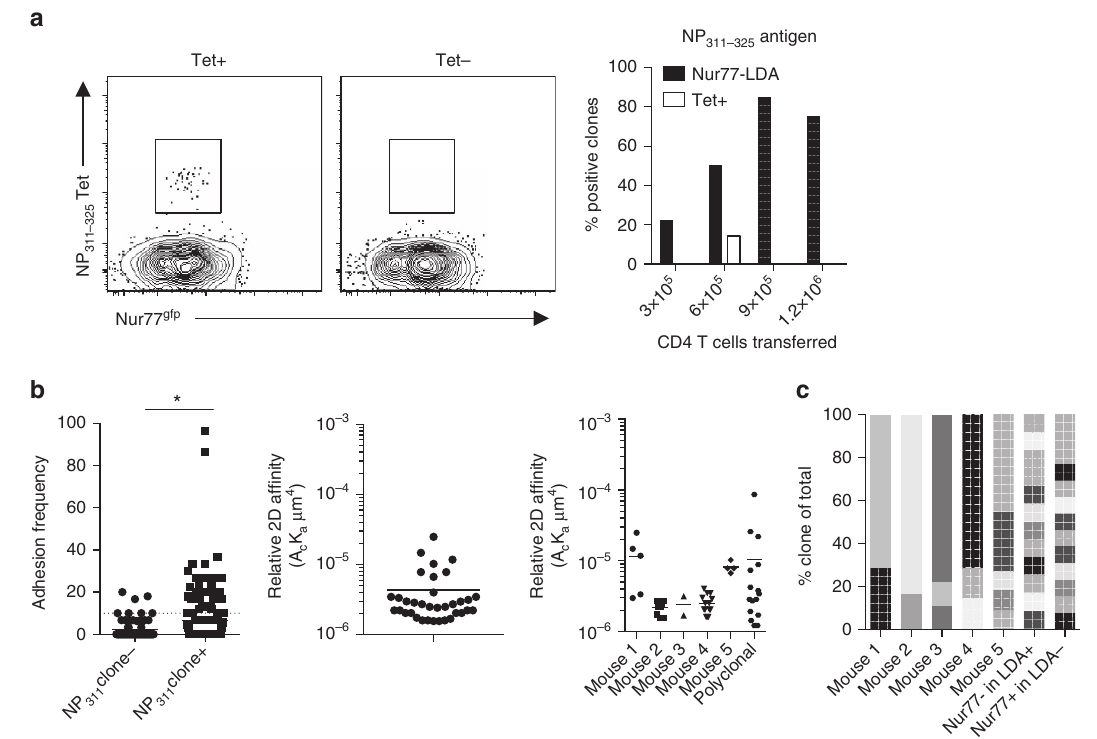
Figure 3 | In vivo LDA identifies low-affinity CD4 þ T-cell clones. ( a ) Representative NP 311–325 Tet staining in TCR a (cid:2) / (cid:2) LDA mice with both a Tet þ positive (left) and negative (right), with only 1 out of 34 mice possessing a Tet þ -positive clone. ( b ) MP on single CD4 þ Tcells isolated from positive and negative LDA mice as identified by CD69/Nur77 (data combined from two independent experiments, n ¼ 2–3 mice, Student’s t -test, * P ¼ 0.0073). MP affinities on individual positive LDA clones following NP 311–325 /CFA immunization along with a separate analysis of the polyclonal repertoire (single points represent individual cells). ( c ) Single-cell TCR b sequencing from LDA-positive and -control mice. Individual colours represent unique TCR b CDR3 sequences, with each column representing a single